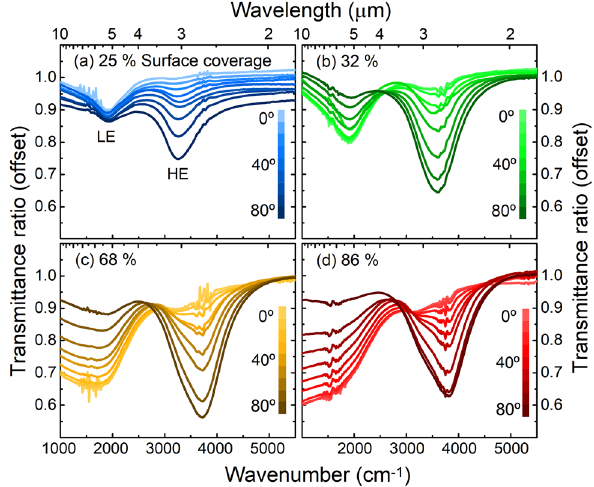
Figure 2: Measured transmittance curves at different angles of incidence (10 ° steps) for increasing NP substrate coverage. (a) 25%, (b) 32%, (c) 68%, and (d) 86%. The transmittance curves of the samples were normalized by the response of a bare semi- insulating GaAs substrate at the same angles of